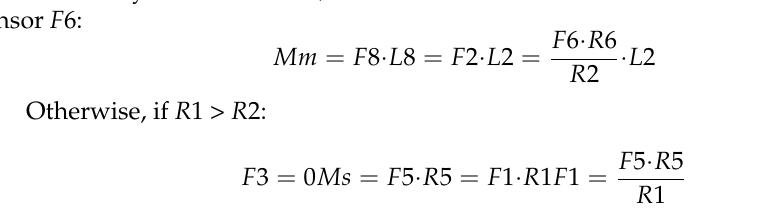
Figure A10. Representation of the masticatory system and the device neglecting internal forces and considering R3 as the moment unloading point.